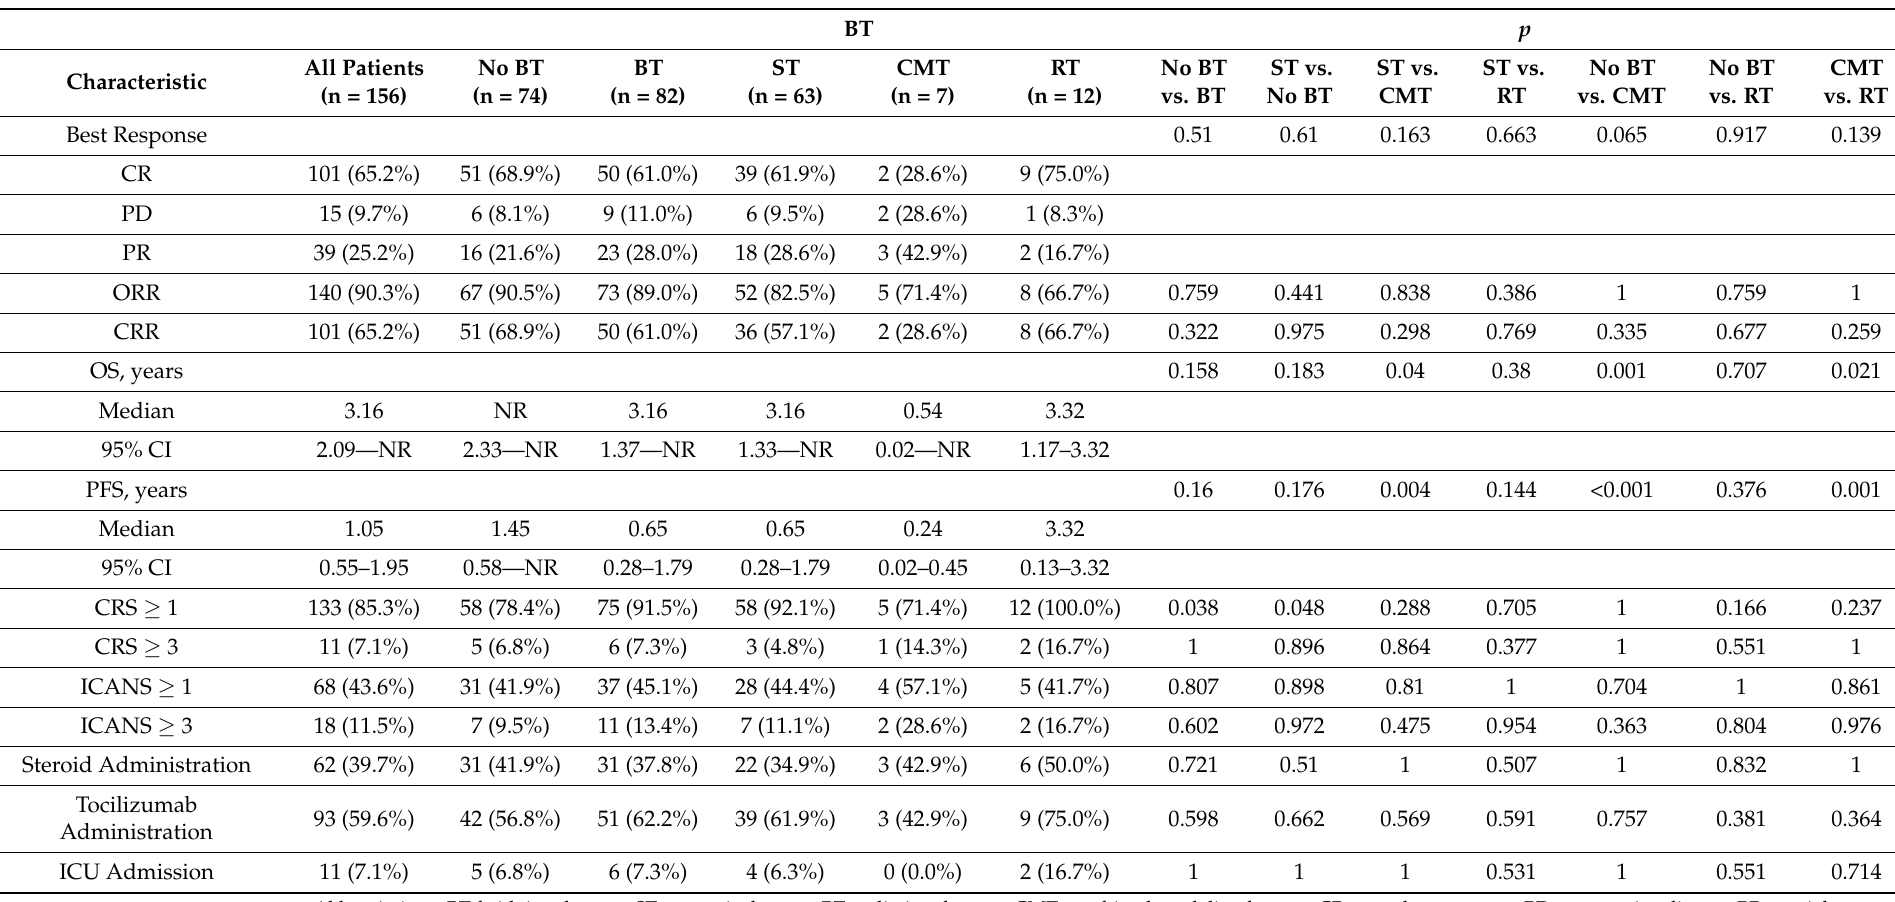
Table 3. Treatment-related toxicity and survival outcomes among patients who received CAR T-cell therapy. BT